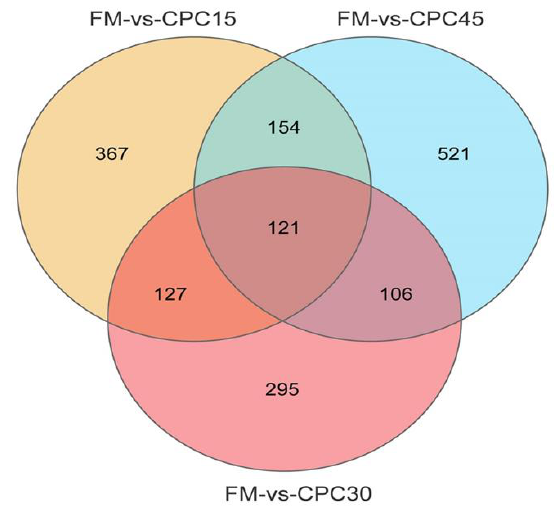
groups. FM groups.